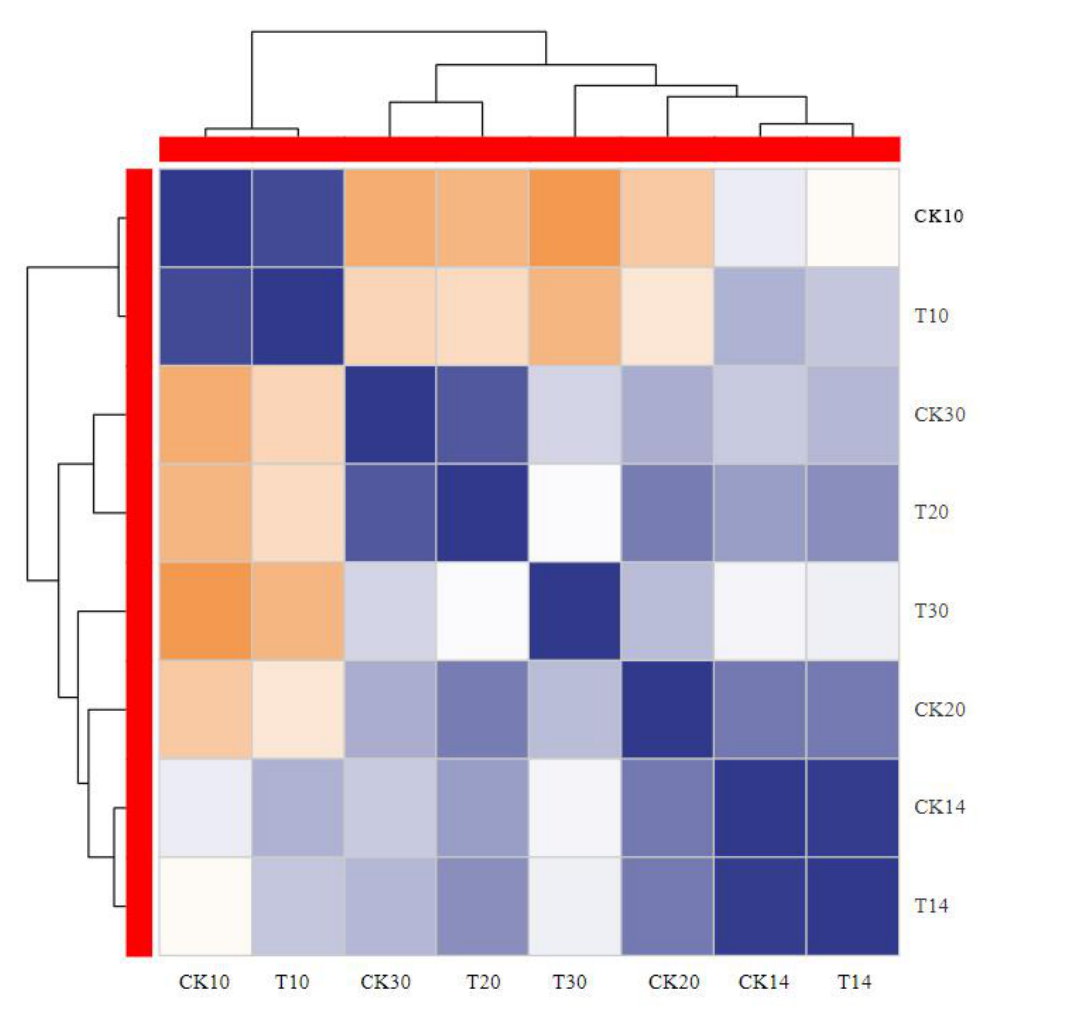
Figure 4. Correlation heat map for all 8 samples. The heat map plots the correlation coefficient score between any two samples. Samples #10, #14, #20, and #30 were clear outliers relative to the other samples.